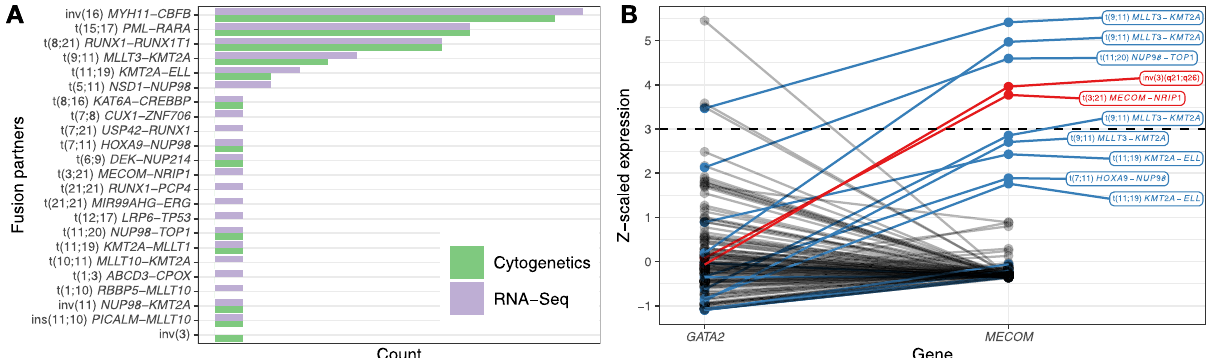
Fig. 2 Structural variation analysis. A Number of structural variation events detected by cytogenetics analysis vs. RNA-Seq fusion detection. B z -scaled gene expression of GATA2 and MECOM in the AML PMP exploratory patient cohort. MECOM - (red) and KMT2A -related (blue) structural variants are colored. The dashed horizontal line indicates the threshold of z ≥ 3 for MECOM outlier